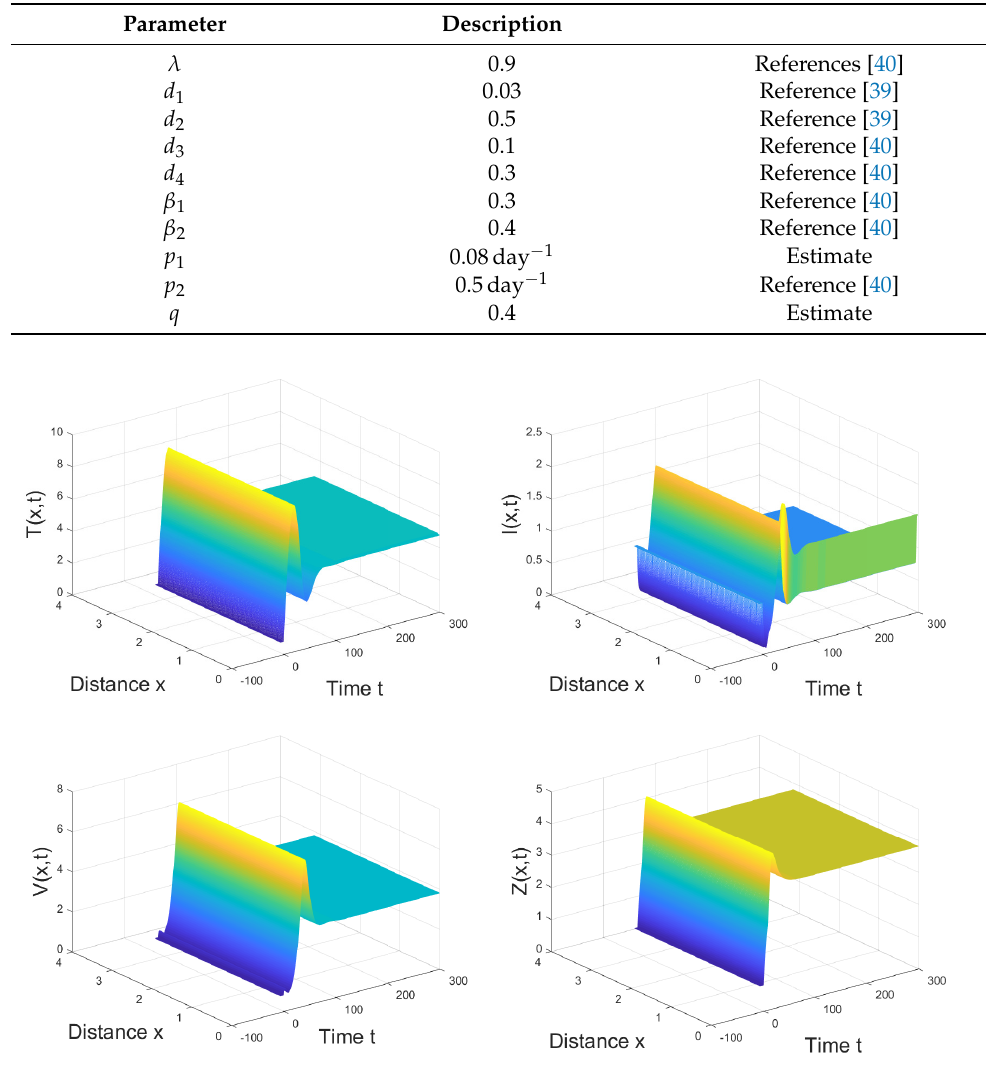
Figure 1. When D = 3, R 1 > 1, the interior equilibrium E 2 is globally asymptotically